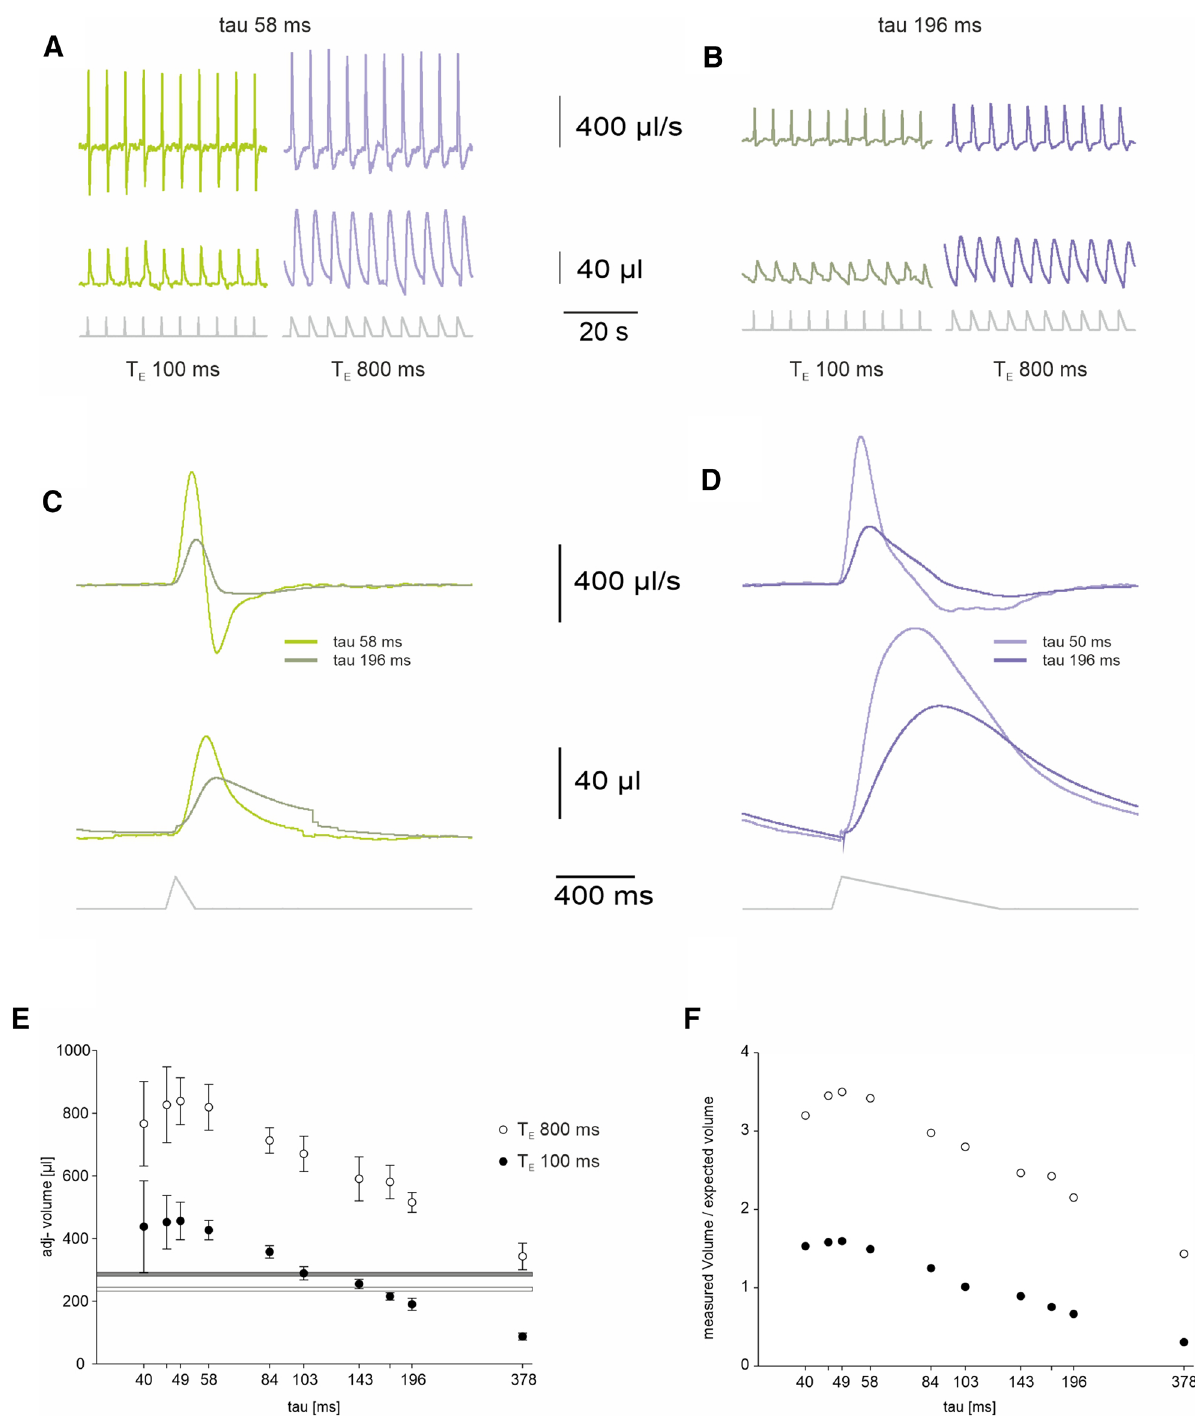
Figure 3. The apparent tidal volume depends on the decay time constant (tau) of the FWBP chamber ( A ) Flow (upper trace) and volume trace from the ALM in a chamber with a pressure decay time constant (tau) of approximately 58 ms for two different durations of expiration (T E 100 ms and T E 800 ms). ( B ) Flow (upper trace) and volume trace from the ALM in a chamber with a pressure decay time constant (tau) of 196 ms for two different durations of expiration (T E 100 ms and T E 800 ms). ( C ) Comparison of the averaged flow (upper traces) and volume traces for respiratory cycles with T E 100 ms from the ALM in two chambers with different corner frequencies. Note that the faster time constant (τ = 58 ms) leads to a larger apparent tidal volume for both durations of expiration (T E 100 ms and T E 800 ms). ( D ) Comparison of the averaged flow (upper traces) and volume traces for respiratory cycles with T E 800. The faster τ (58 ms) leads to a larger apparent tidal volume. ( E ) The plot shows the adjusted tidal volume of the ALM in relation to the time constant of the chamber (tau [ms]). Filled circles are from respiratory cycle with T E 100 ms (TI 50 ms), open circles from T E 800ms cycles; error bars equal standard deviation. The gray bar represents the adjVolume from the volume calibration (Fig. 1) for T E 100 ms, the white bar the data for T E 800 ms (upper and lower edge of bar = ± STD). ( F ) Comparison of the difference between measured adjTV and known TV of the